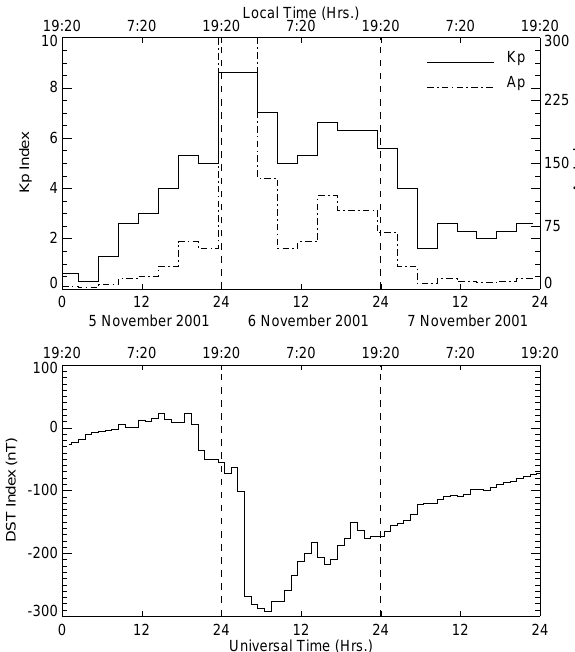
Fig. 1. (Top): K p and A p indices for three days 5–7 November 2001. The scales for K p and A p are shown on the left and right axes, respectively. K p index shows a value of more than 4 dur- ing the late afternoon hours on 5 November. 6 November is a dis- turbed day with both K p and A p indices of 9 − and 300 respec- tively. The magnetic disturbance effect is not seen over low lat- itudes on 5 and and 7 November, as can be seen by the low A p indices on these days. (Bottom): D st variation for the three days under study is shown. The vertical dashed line in both the panels show the 00:00 UT time for the 6 and 7 November data. Storm sudden commencement occurred on the early hours of 6 November and the D st reached a value of − 300nT, indicating a severe storm occurrence. Local time is indicated in the topside of the